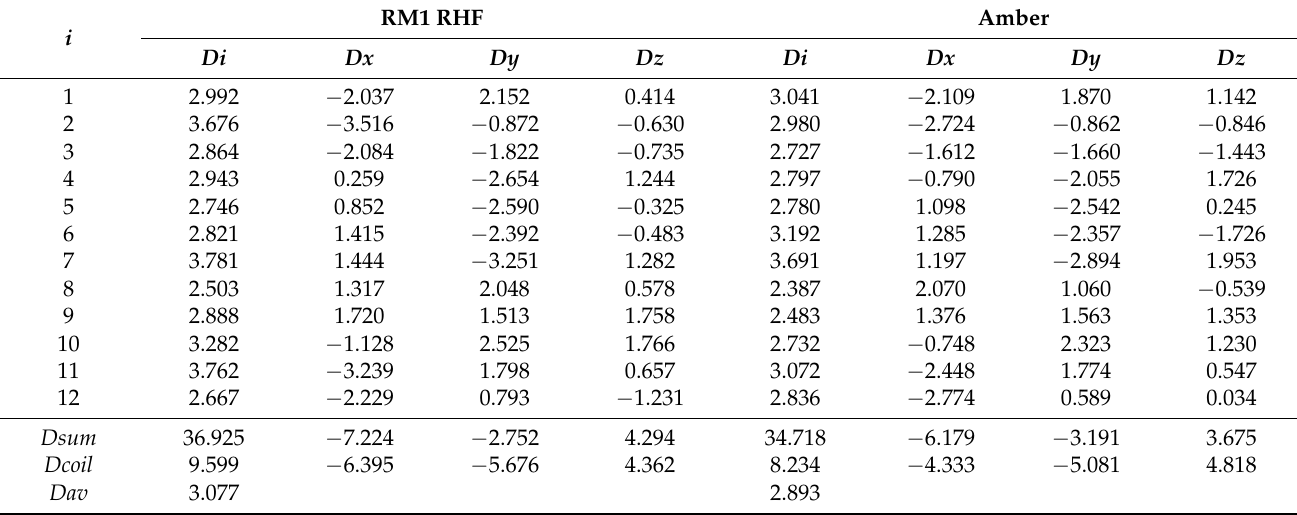
Table 5. Values of dipole moments for a coil of the helix-like D-F PNT computed using RM1 (RHF) and Amber (after RM1) methods. All values of dipole moments are given in Debye units.